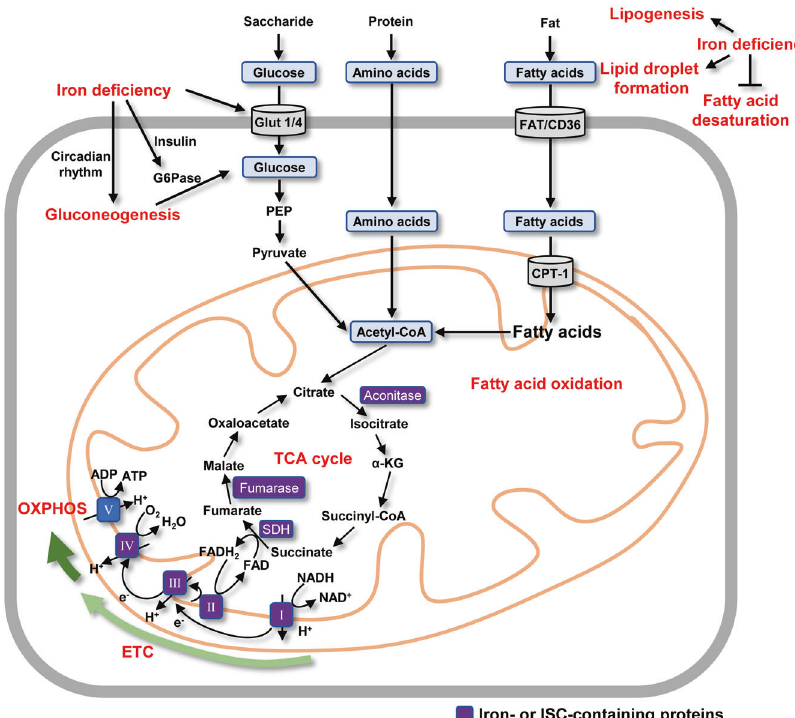
Fig. 2 Roles of iron in the metabolism of glucose, lipids, and amino acids and, in energy production. Iron de fi ciency can increase intracellular glucose levels by promoting glucose uptake and gluconeogenesis. Lipid metabolism is also altered in response to iron de fi ciency through increased lipogenesis and lipid droplet formation, and the inhibition of fatty acid desaturation. The metabolism of glucose, lipids, and amino acids converges in mitochondria at the point of acetyl-CoA, which enters the TCA cycle for energy production. Iron levels can also modulate the synthesis of several key enzymes in the TCA cycle, including aconitase, SDH, and fumarase, and complexes I, II, III, and IV in the